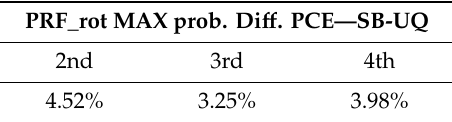
Table 8. Rotor pressure ratio maximum absolute probability di ff erences from SB-UQ approach.